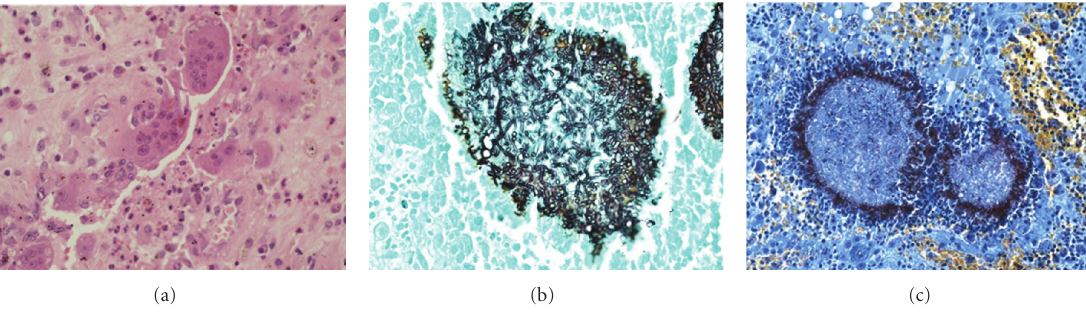
Figure 4: Histological findings on biopsy from the right hand. Multinucleated giant cell reaction (a). Grocott’s stain demonstrating branching, septate hyphae (b). MSB stain demonstrating fungal colonies surrounded by a fibrin halo Splendore-Hoeppli’s phenomenon